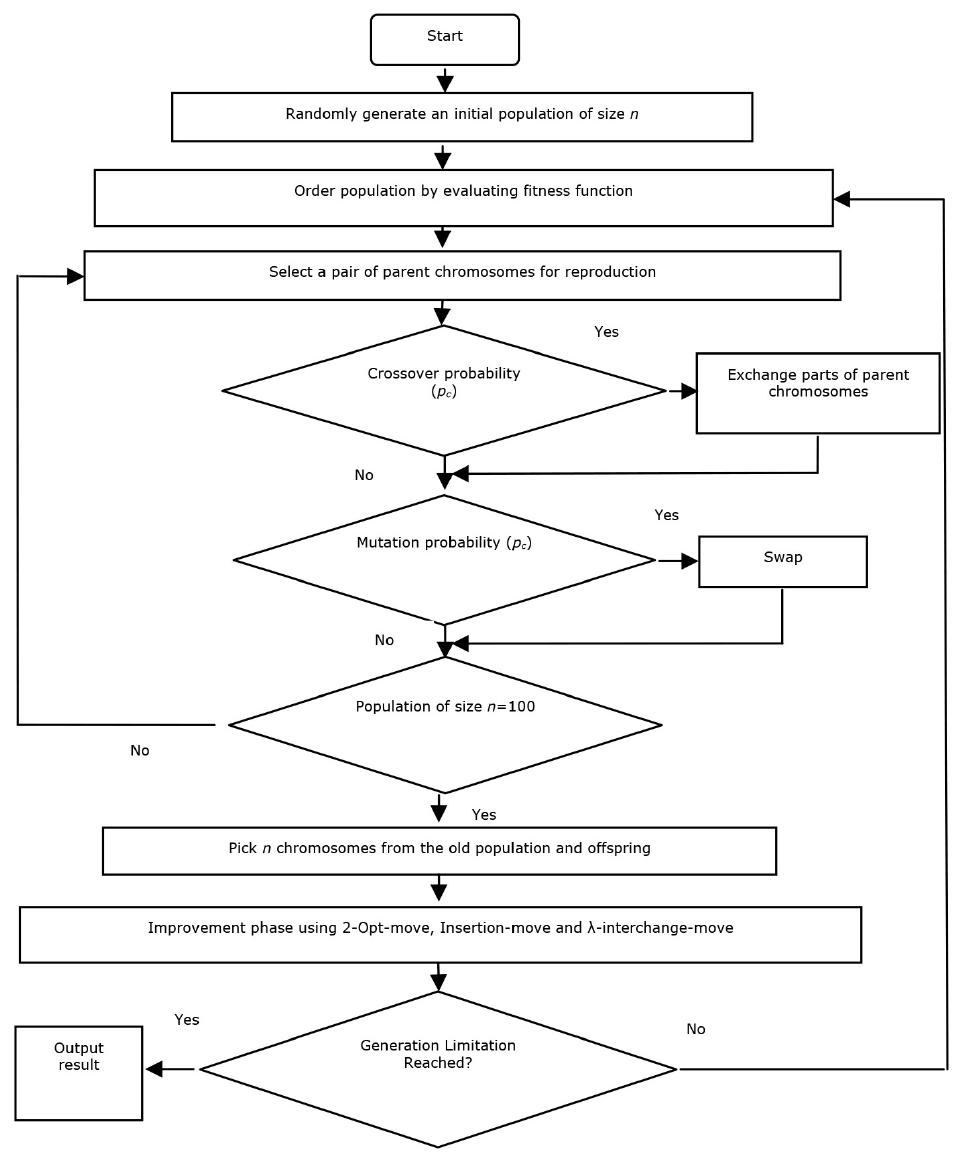
Figure 3. Flow chart of solution of VRP using hybrid